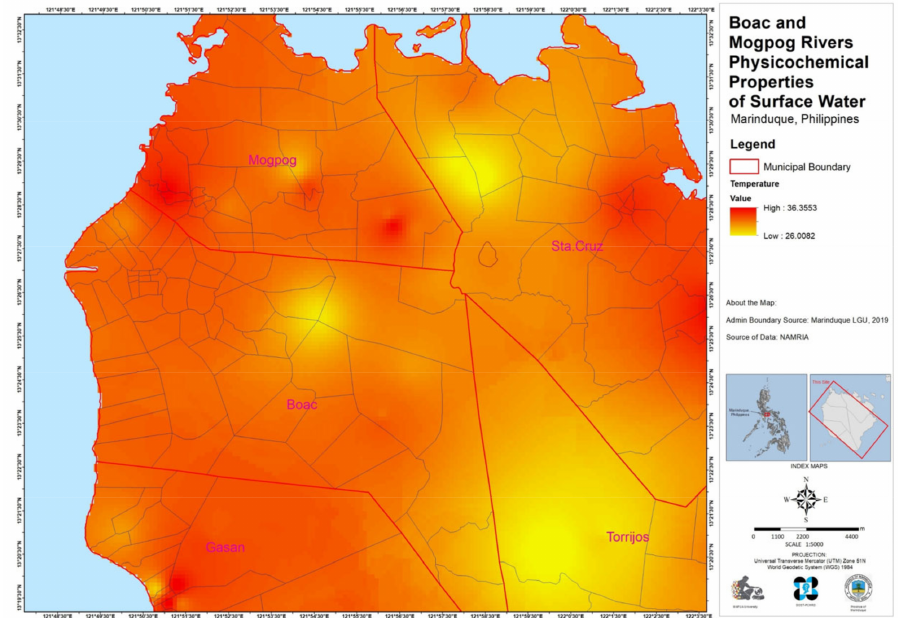
Figure A5. Spatial map for